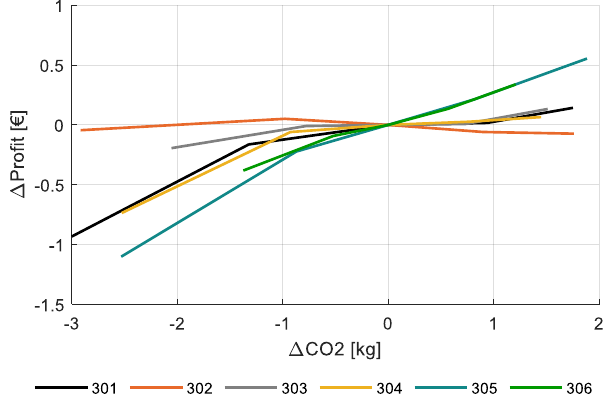
Figure 19. Change in simulated net profit (€/m 2 ) for varying CO 2 supply (kg/m 2 ) for the different greenhouse compartments (301 – 306).